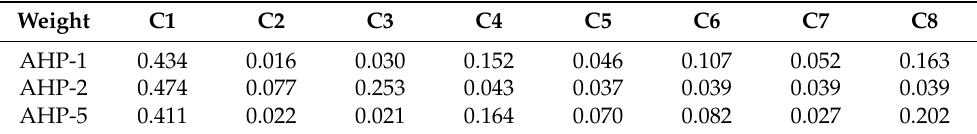
Table 6. The weights of the predictive factors suggested for the best three AHP models. Weight